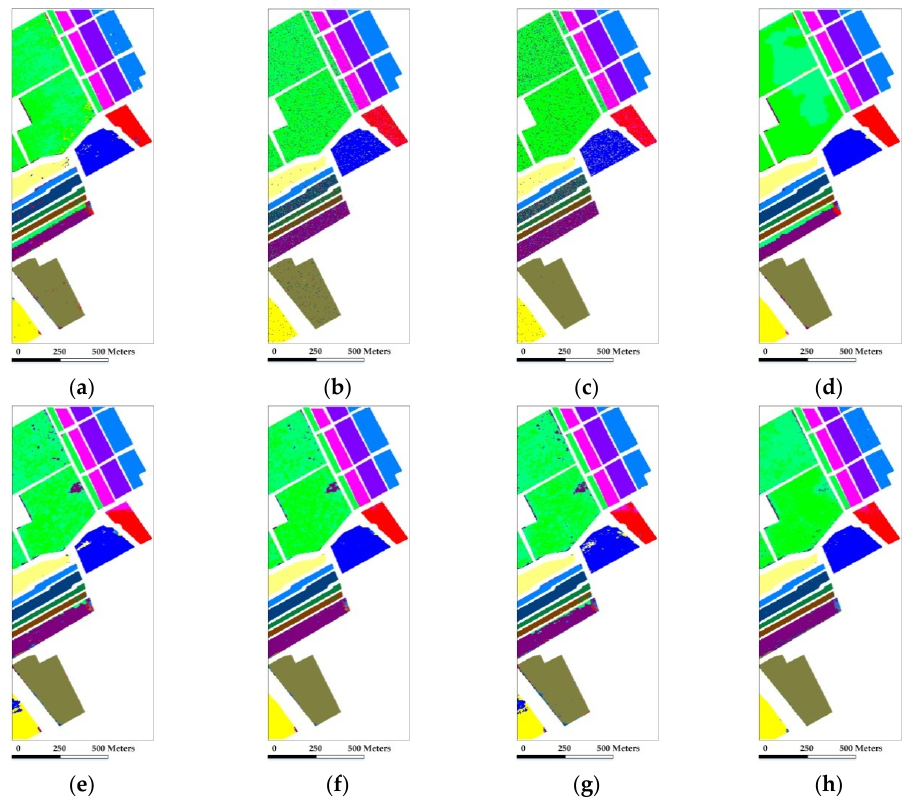
Figure 7. Classification maps obtained by the different tested method for the AVIRIS Salinas scene (OA are in parentheses): ( a ) SVM(81.63%); ( b ) CRC (81.03%); ( c ) SRC (81.49%); ( d ) SVM-MRF (85.27%); ( e ) JSRC (84.49%); ( f ) GSRC (88.11%); ( g ) NL-SRC (88.62%); ( h ) NSLS-GSRC (91.06%).